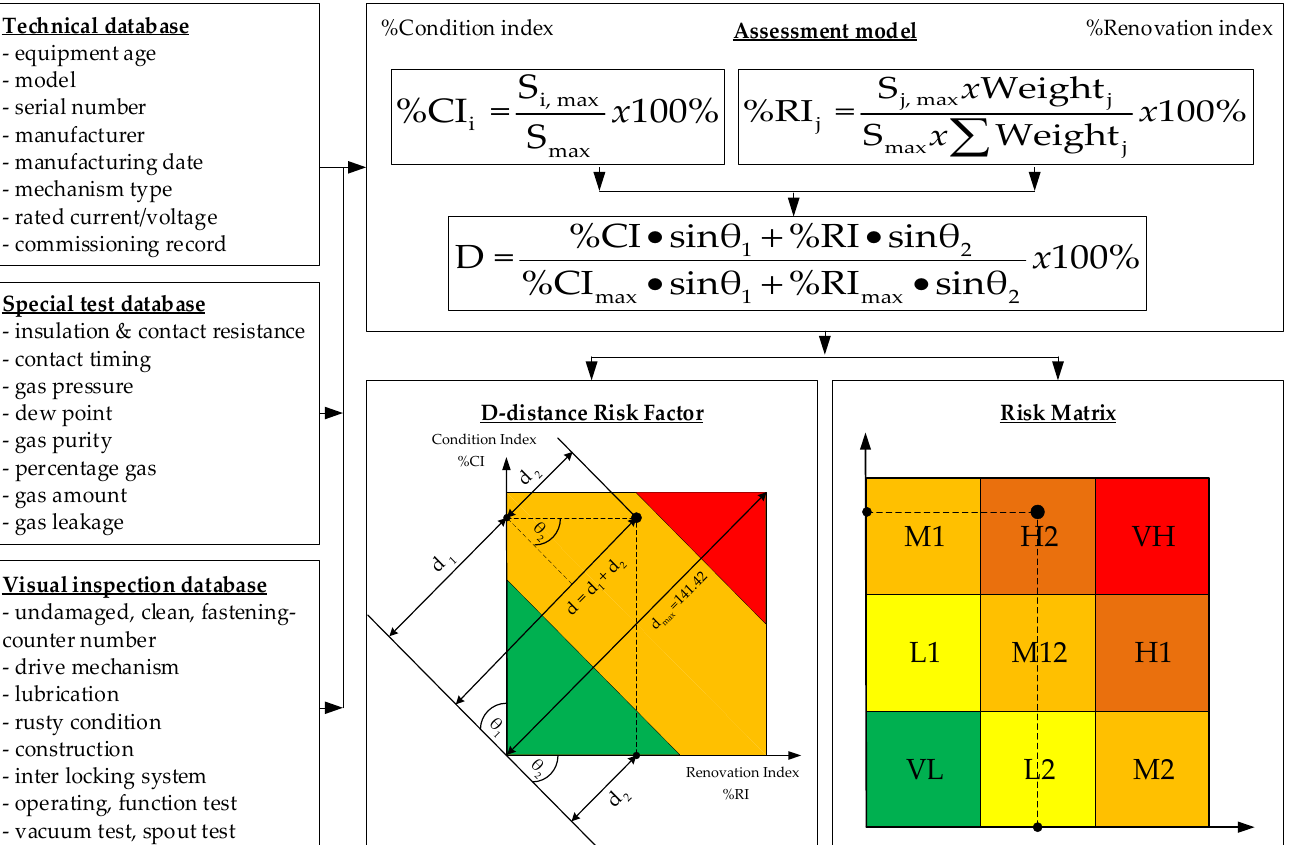
Figure 2. The overall procedure of the assessment model.